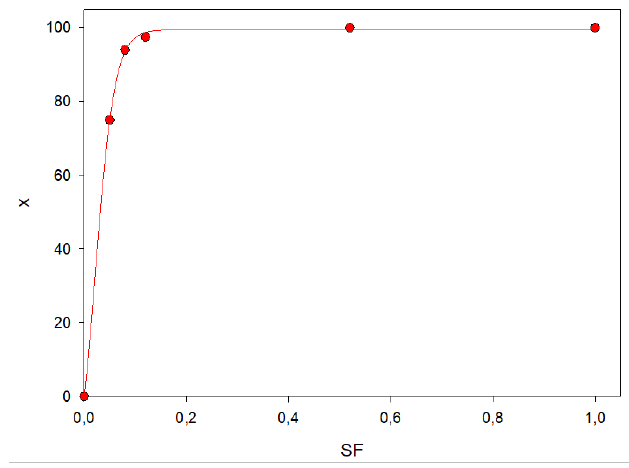
Figure 7. Cellobiose conversion x (%) over SF .